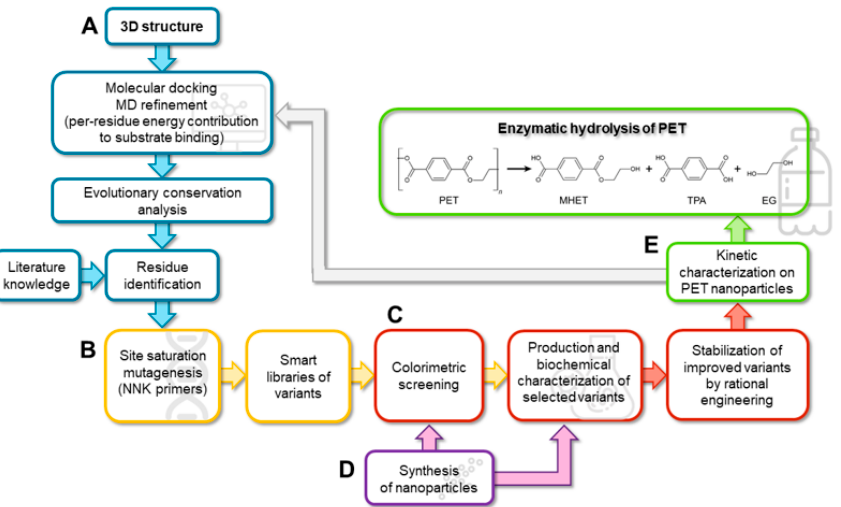
Figure 1. Scheme of the proposed multidisciplinary workflow for producing improved variants of PHEs by SSM and rational protein stabilization. ( A ) Blue, in silico design; ( B ) yellow, molecular biology; ( C ) red, biochemistry; ( D ) purple, chemistry; ( E ) green, biocatalysis.